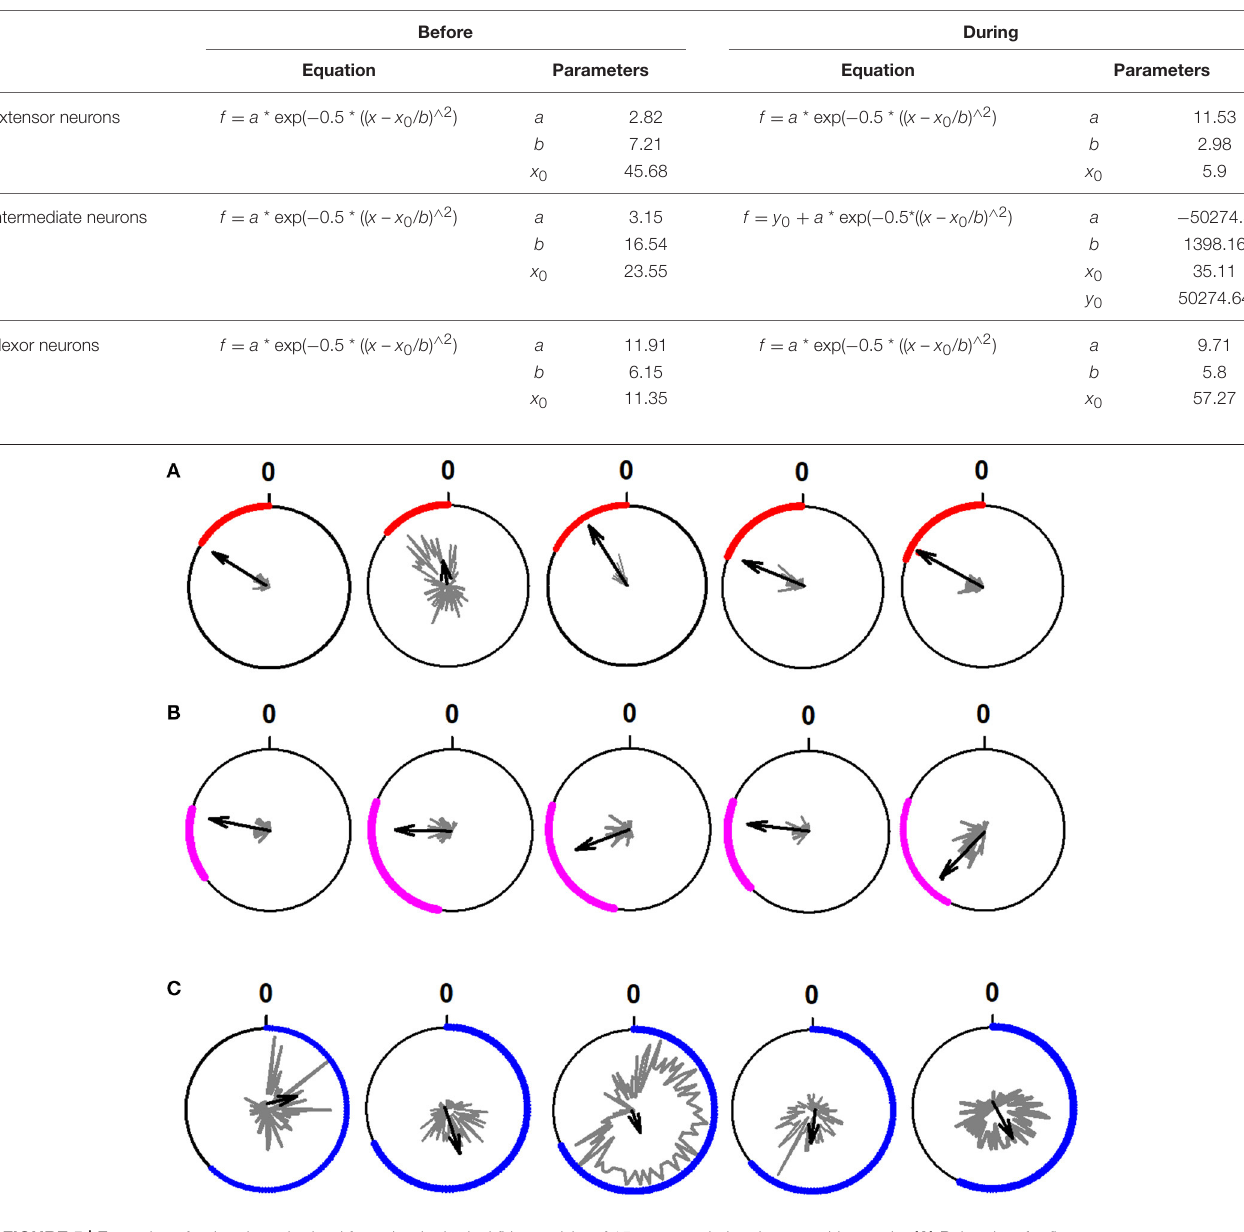
FIGURE 5 | Examples of polar plots obtained from the rhythmical firing activity of 15 neurons during the scratching cycle. (A) Polar plots for five extensor neurons. (B) Polar plots for five intermediate neurons. (C) Polar plots for five flexor neurons. We determined the rhythmicity of the neurons through the statistical analysis of the firing activity of the neurons employing circular statistics and the Rayleigh test ( p < 0.05). The polar plots show the phase of the interneuronal firing activity relative to the cycle of the TA nerve. The length of the black arrows represents the mean neuronal firing discharge. The direction of the black arrows indicates the phase preference of the rhythmical